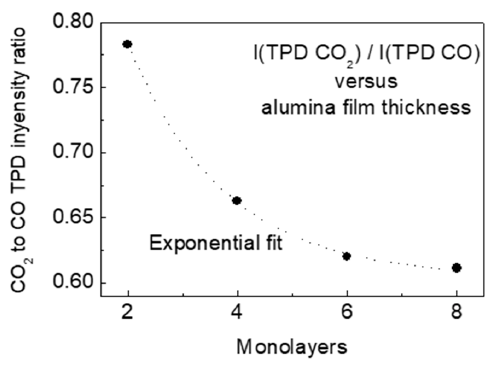
Figure 5. Ratio of TPD peak intensity of CO 2 to CO versus the alumina film thickness (points) and the exponential fit (dotted the exponential fit (dotted line).